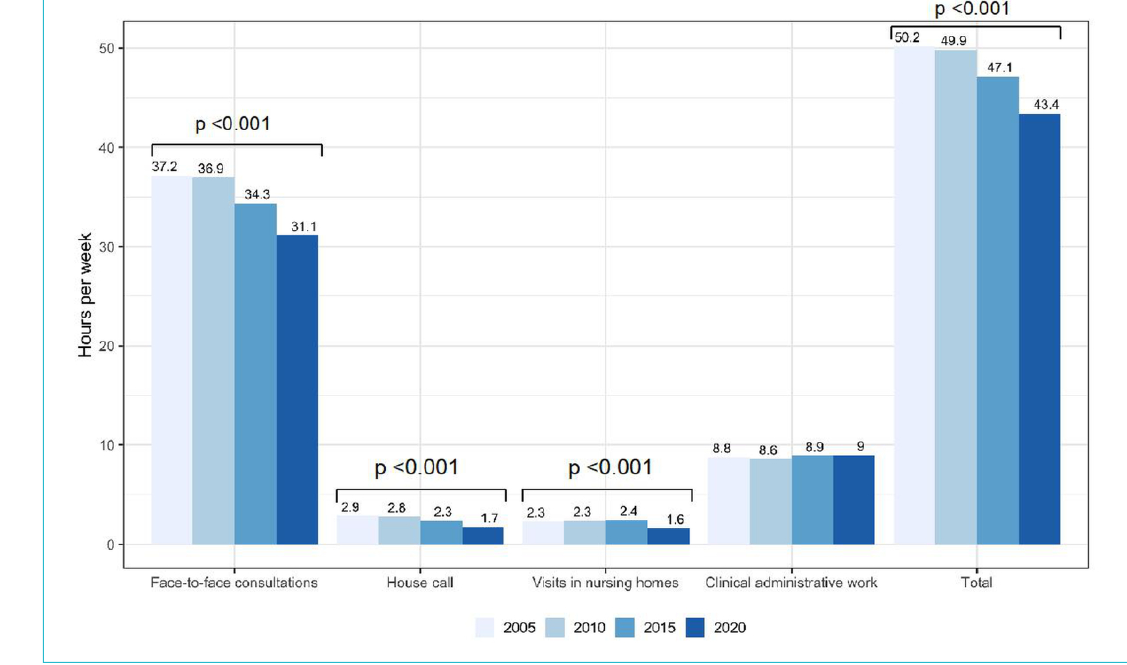
Figure 2: Workload in face-to-face consultations, house calls, visits to nursing homes, clinical administrative work, and total workload for years 2005–2020. P-values indicate significant (p <0.001) workload changes across years within types of